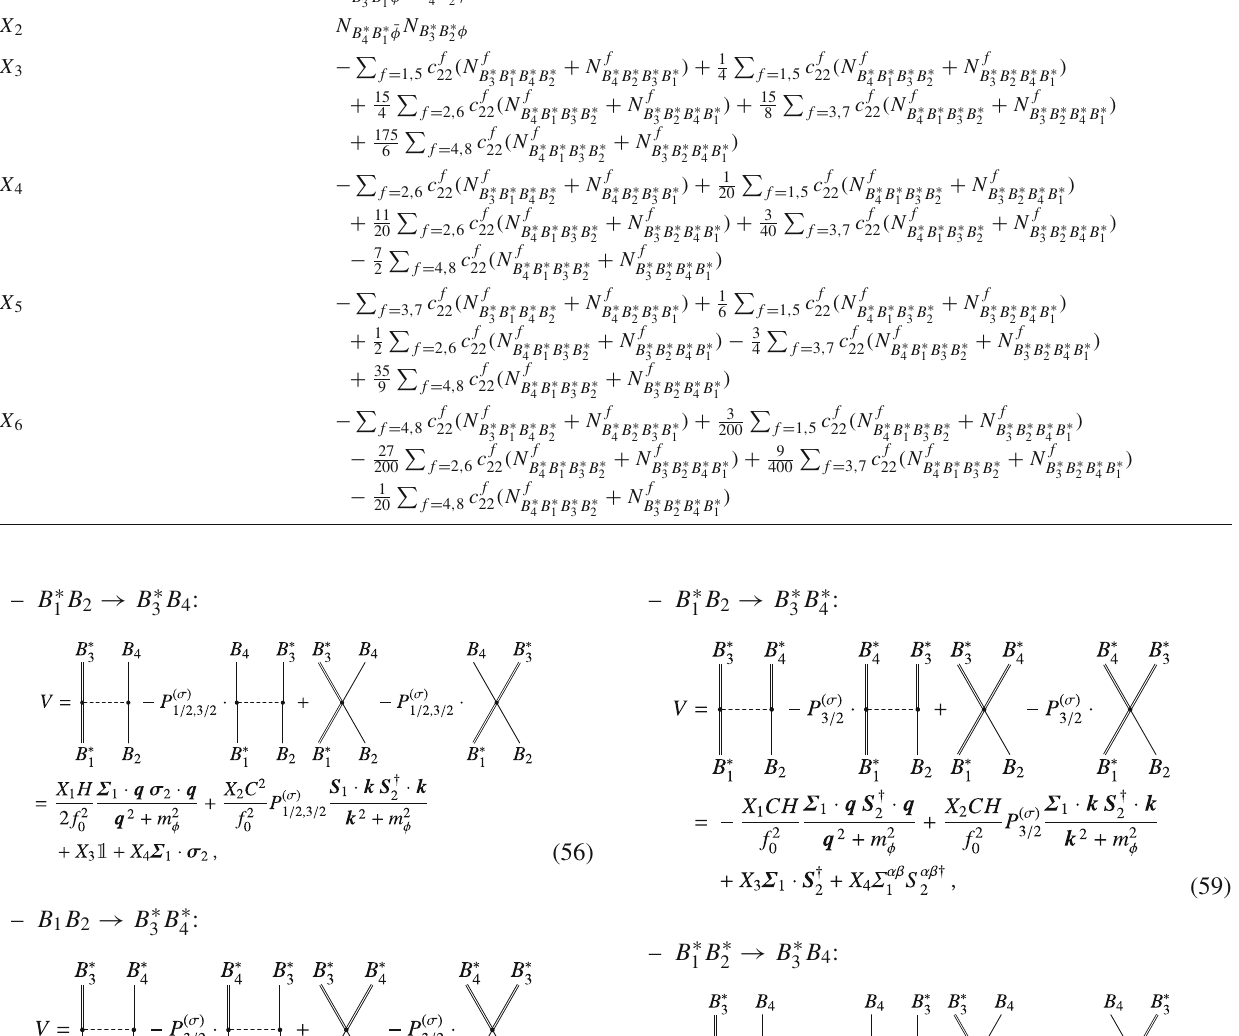
Table 5 Coefficients X i for the transition B ∗ X